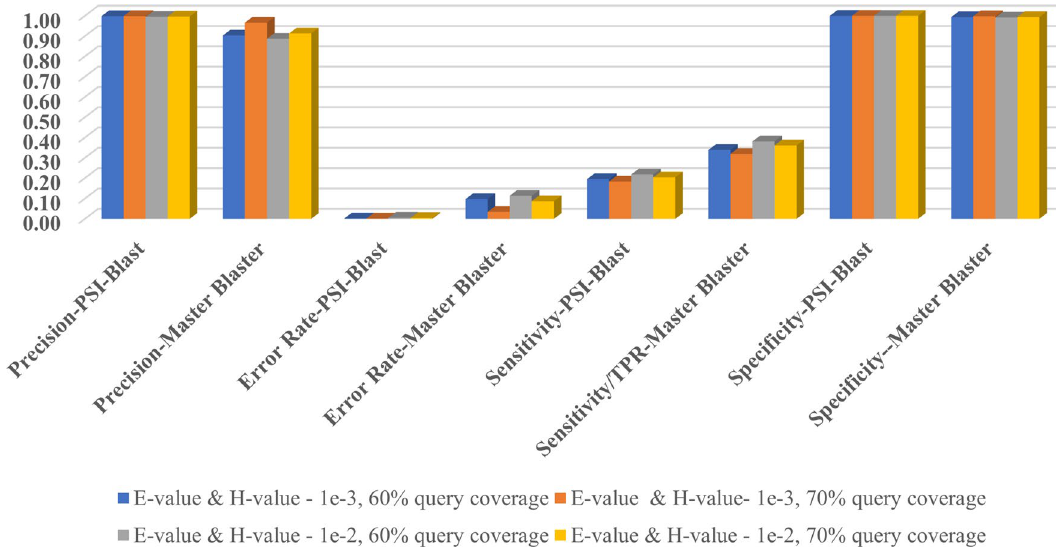
Figure 2. Comparative assessment of PSI-BLAST, and Master Blaster using different parameters.